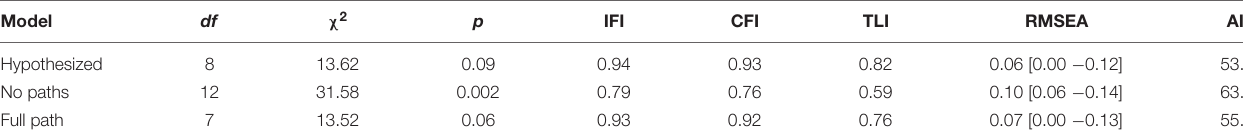
TABLE 3 | Fit indices for structural models of mindfulness, executive functions, and critical thinking.